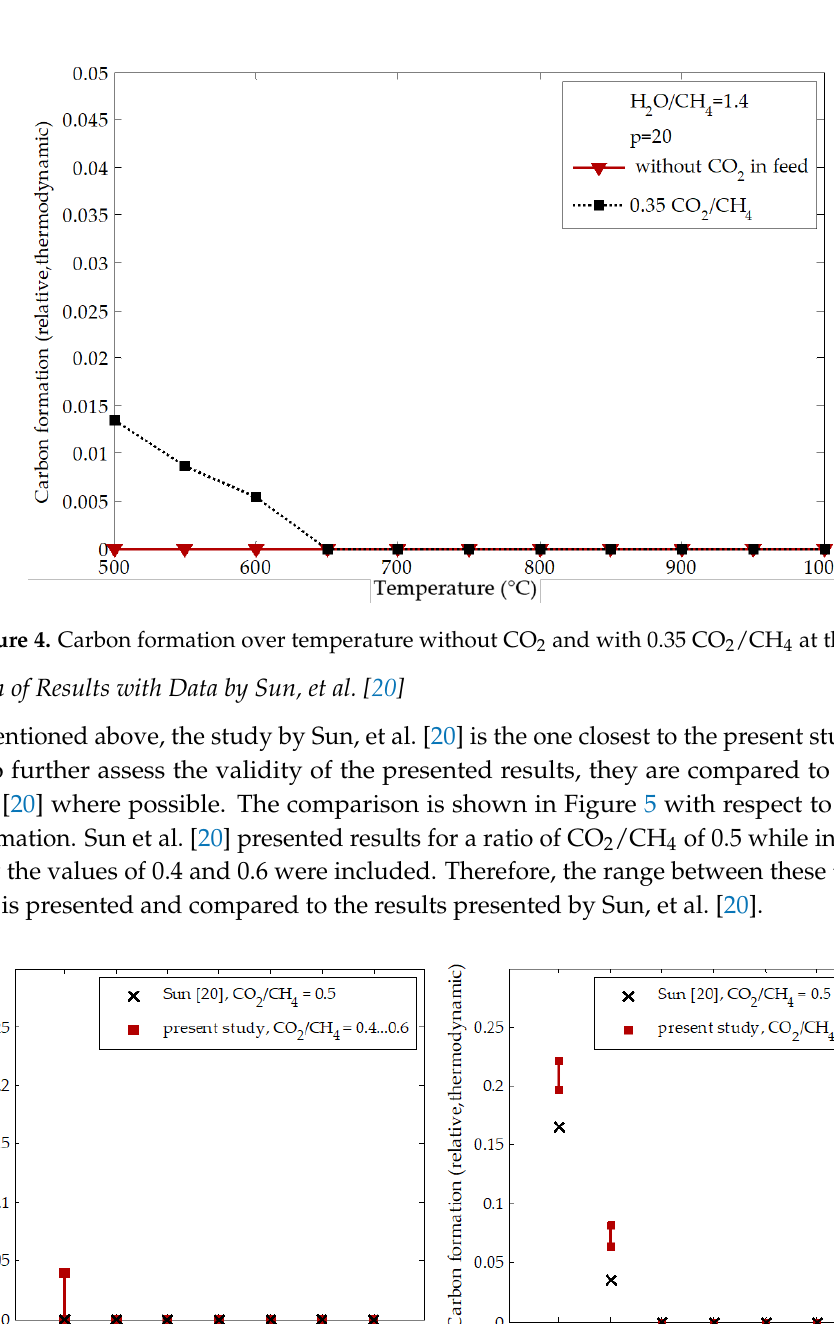
Figure 5. Comparison of carbon formation results with results presented by Sun, et al. [20]. For H 2 O/CH 4 = 1 at 1 bar ( a ) and 5 bar ( b ).